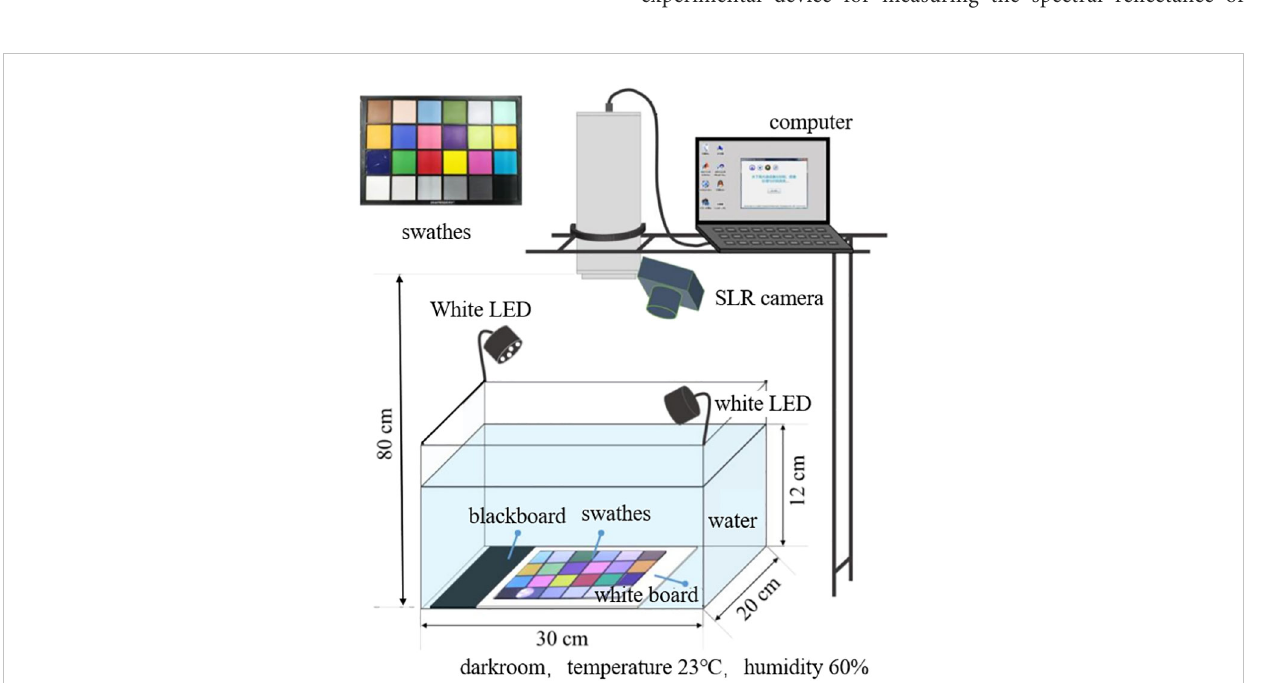
FIGURE 3 Schematic diagram of the experimental setup to measure the underwater spectral re fl ectance by LCTF-based spectral imaging system under varying conditions of turbidity and